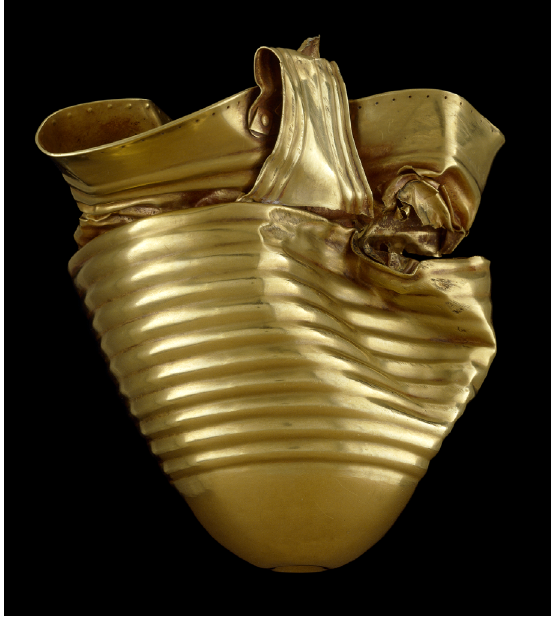
Fig.1: The Ringlemere Cup, which was reported Treasure to the author when he was Finds Liaison Officer for